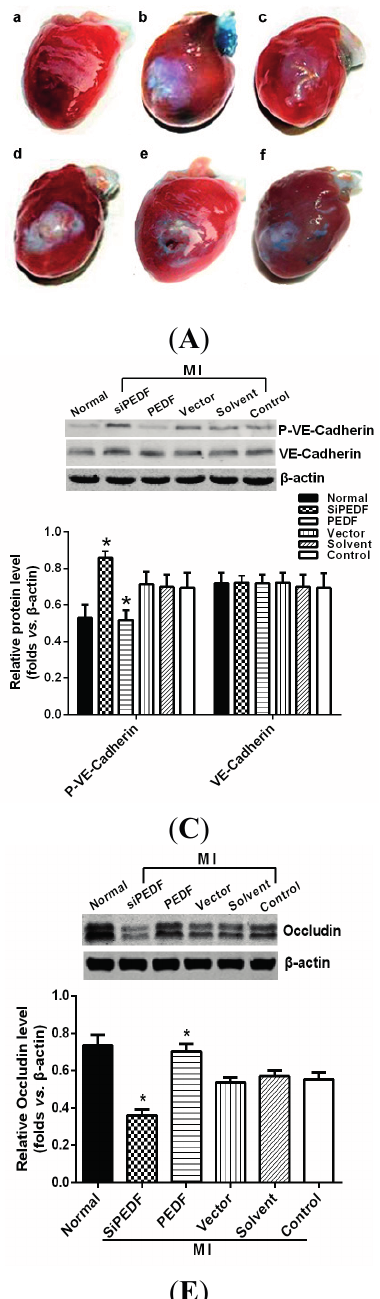
Figure 4. Vascular permeability in the ischemic heart. ( A ) The representative figures show the following: (a) normal, (b) SiPEDF, (c) PEDF, (d) vector control, (e) solvent control and (f) ischemic control; ( B ) Quantification of the Evans Blue content; ( C ) Western blot determination of VE-cadherin/VE-cadherin tyrosine phosphorylation; ( D ) Co-immunoprecipitation of VE-cadherin/ β -catenin complexe; and ( E ) Western blot determination of occludin. Data are expressed as the mean ± SD ( n = 6). * p < 0.05 vs. the control